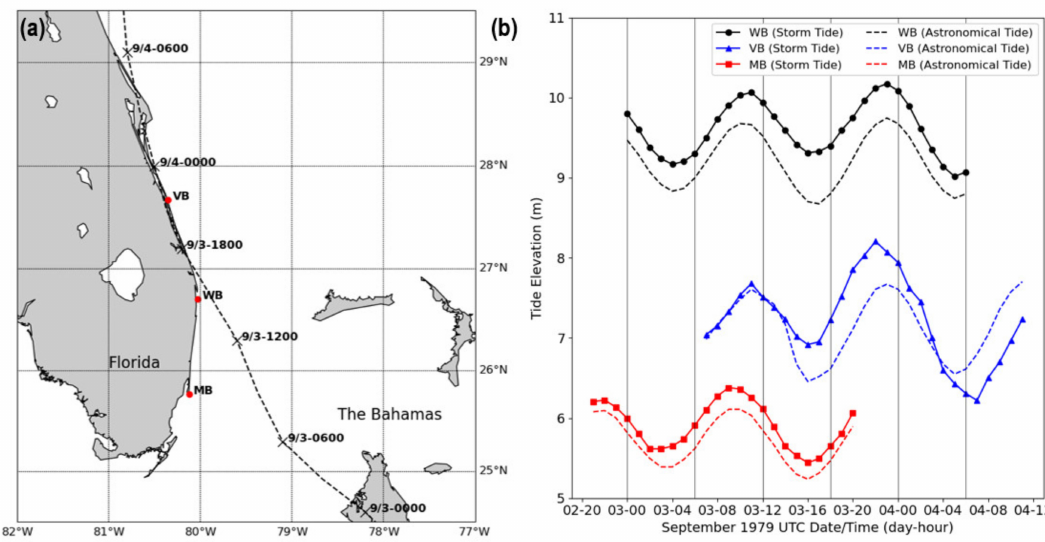
Figure 5. ( a ) Track of Hurricane David over eastern Florida and ( b ) recorded storm tide depth relative to the astronomical tide at MB, WB, and VB monitoring stations over their time intervals of interest (extracted from Howell et al.